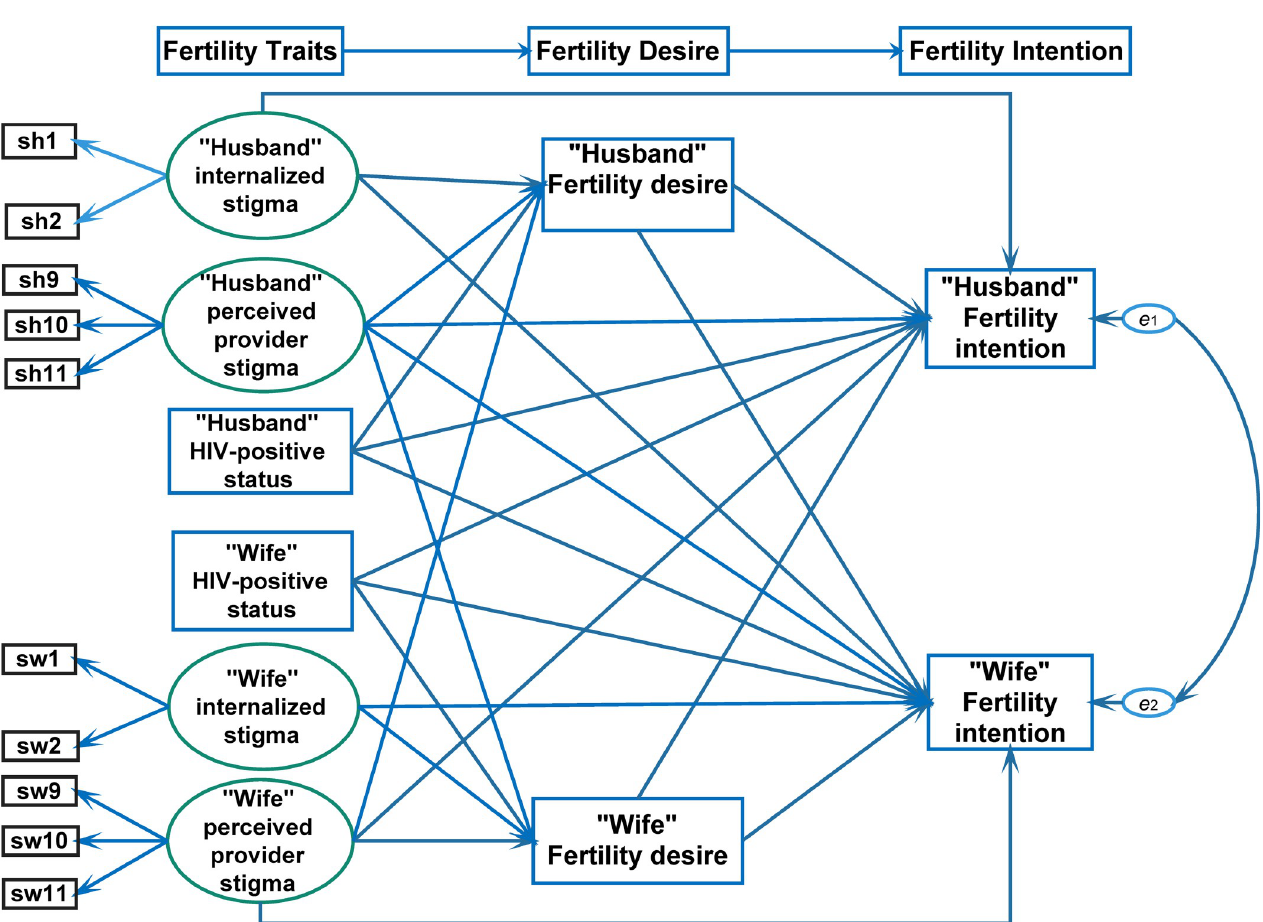
Fig 1. Hypothesized framework for fertility intention among monogamous HIV concordant and discordant couples.